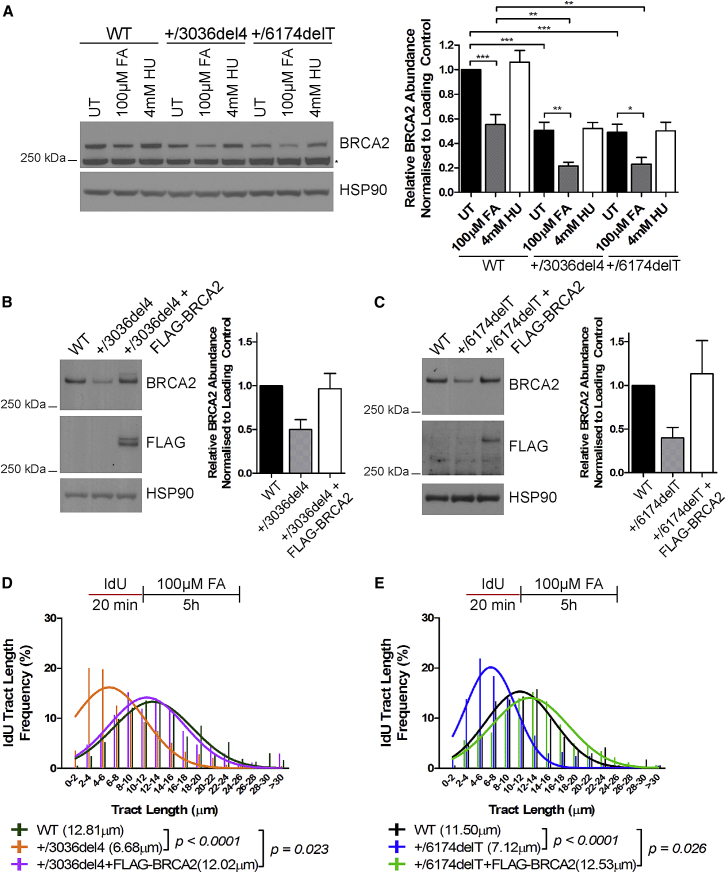
BRCA2 Complementation in BRCA2 Heterozygous Cells Is Sufficient to Counteract Formaldehyde-Induced Replication Stress(A) BRCA2 abundance in HeLa Kyoto cells treated as indicated for 5 hr. Mean ± SEM of BRCA2 band intensities normalized to loading controls are plotted, n = 8.(B and C) BRCA2 abundance in (B) BRCA2+/3036del4 and (C) BRCA2+/6174delT heterozygous cells complemented with FLAG-BRCA2, plotted as in (A).(D) IdU tract length frequency distributions of BRCA2+/3036del4 heterozygous cells complemented with FLAG-BRCA2 after FA exposure for 5 hr.(E) IdU tract length frequency distributions of BRCA2+/6174delT heterozygous cells complemented with FLAG-BRCA2 after FA exposure for 5 hr. Results of D and E represent two independent experiments.See also Figure S5.